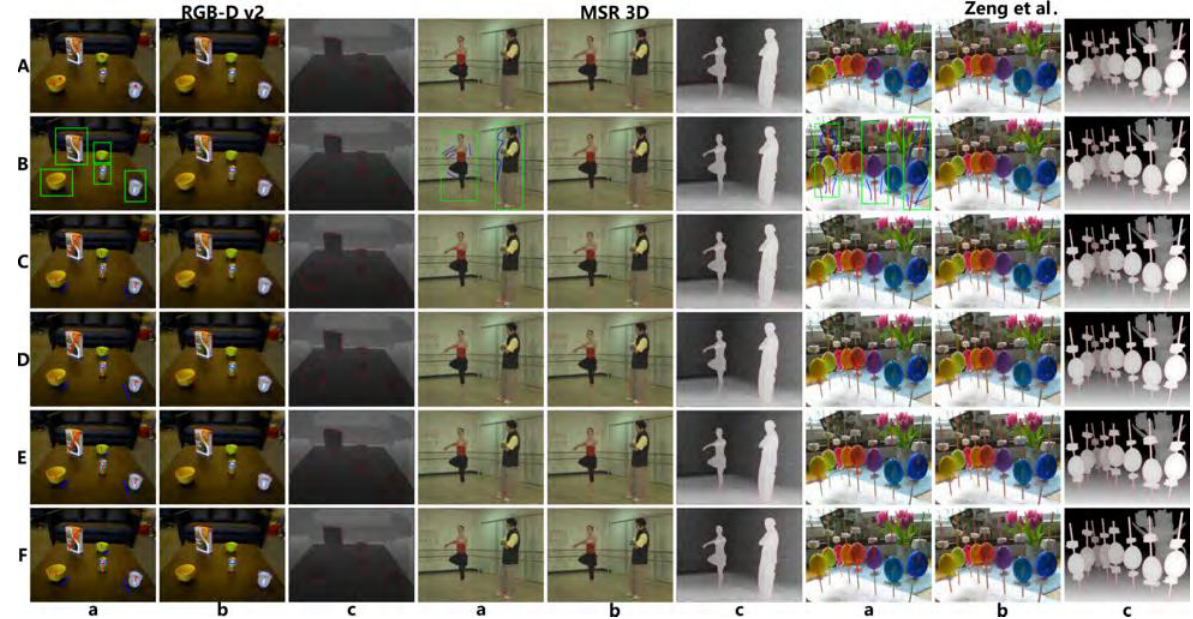
Fig. 4 Foreground objects and silhouettes extracted by different methods in both color and depth. (A) Magic wand, (B) grab-cut [6], (C) graph-based on color information only (i.e., baseline method), (D) the fast mode of Ref. [5] with depth layers, (E) mean-shift color-depth with depth layers, and (F) our approach. (a) Interactions, (b, c) extraction results in color and